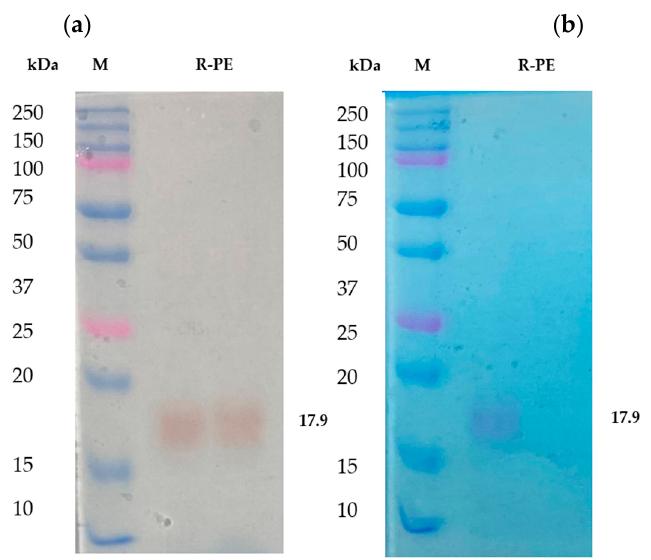
Figure 3. The purified R-phycoerythrin alpha subunit was analyzed in 12.5% SDS-PAGE. ( a ) Un- stained polyacrylamide gel with M: molecular weight marker, R-PE-purified phycoerythrin alpha subunit from Pyropia yezoensis. ( b ) Polyacrylamide gel stained with Coomassie brilliant blue R-250, 10 μ g of protein sample were loaded in each well M: molecular weight marker; R-PE-purified phy- coerythrin alpha subunit from Pyropia yezoensis.